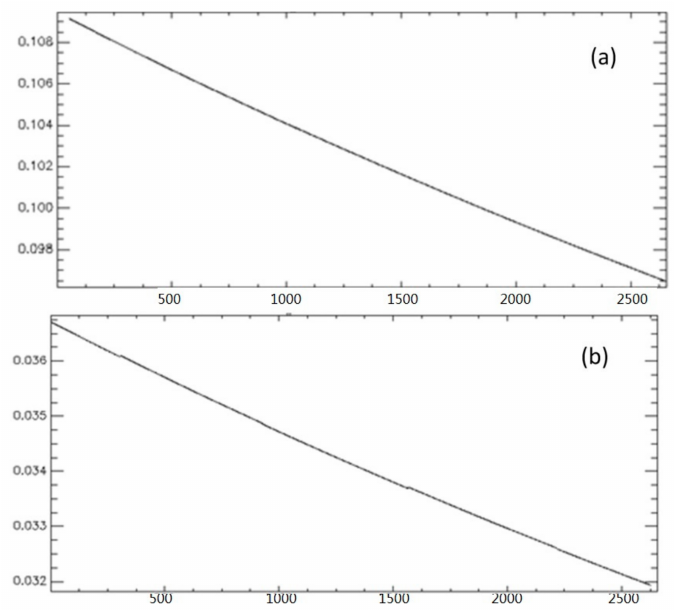
Figure 6. The gradient map of kz in range orientation: ( a ) 73–75; ( b ) 93–95 (X: distance; Y: kz